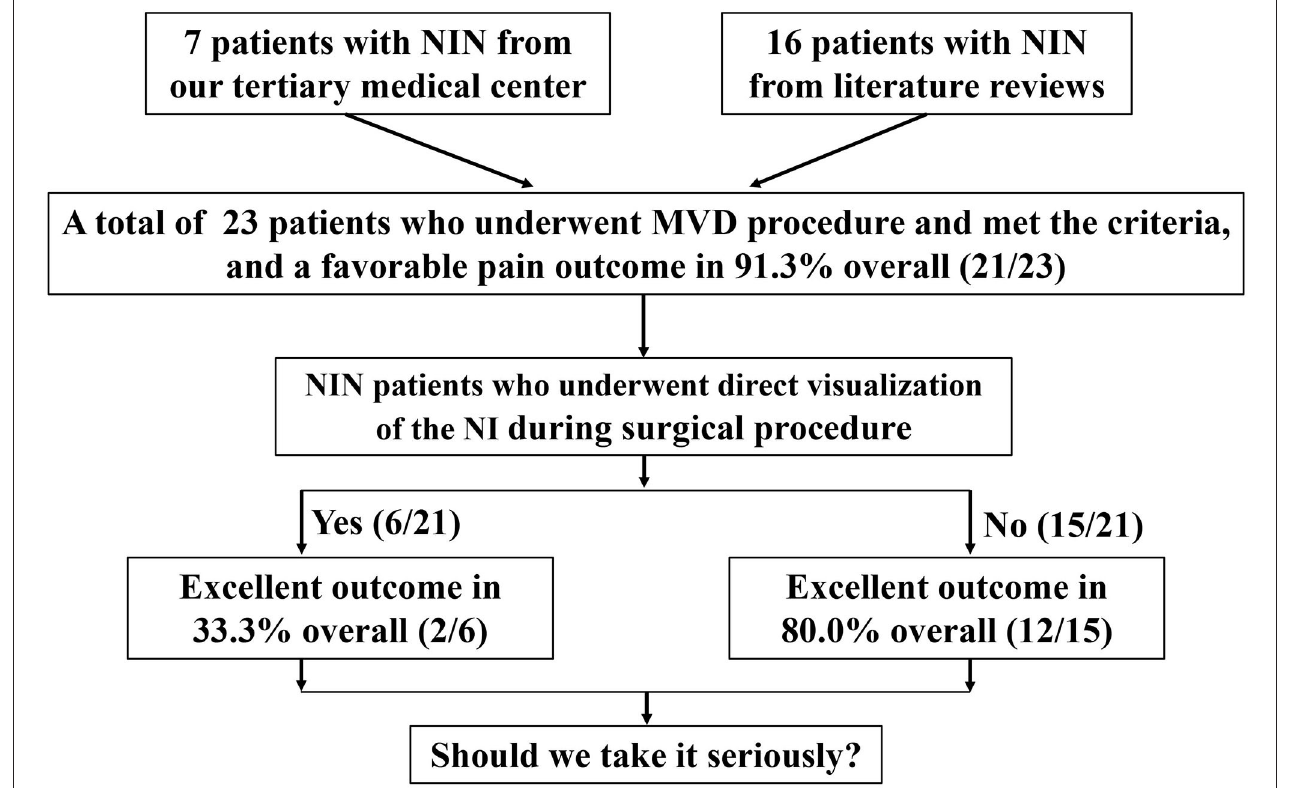
FIGURE 1 | A flowchart of the recruitment and clinical trajectories for 23 patients who underwent